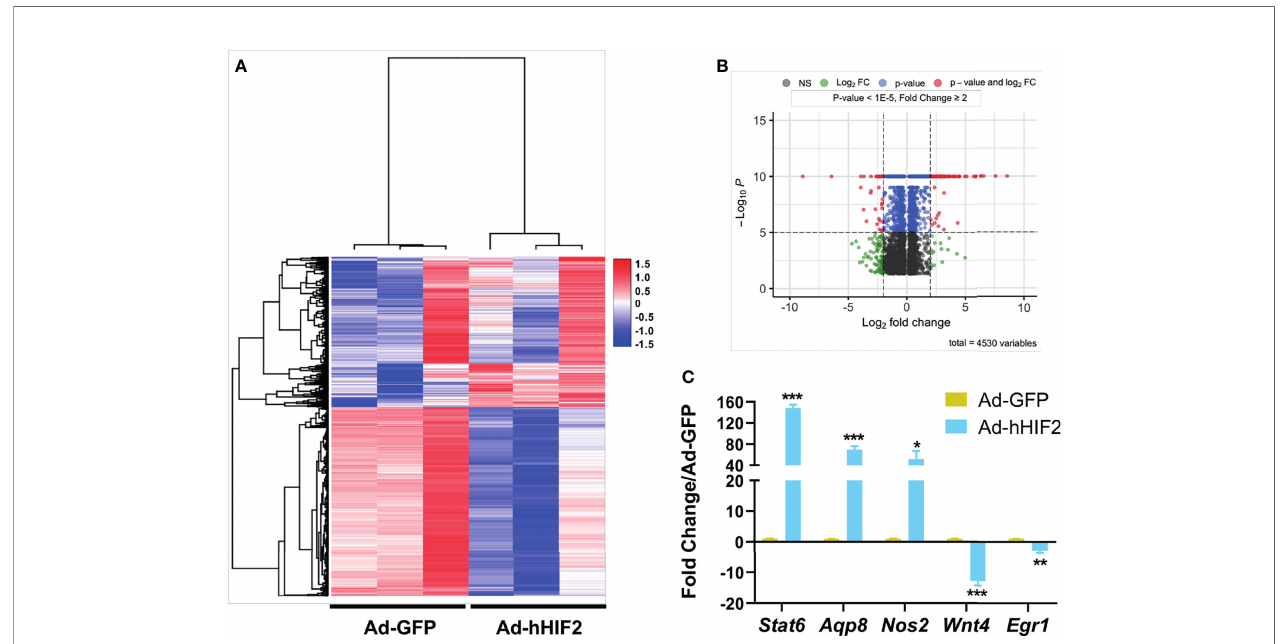
FIGURE 2 | Differentially expressed gene pro fi le in HIF2-overexpressing duodenal organoids. (A) Heatmap shows all the differentially expressed genes in duodenal organoids infected with Ad-hHIF2 or control Ad-GFP evaluated via RNA sequencing (n = 3 biological replicates/group). (B) Volcano plot of the differentially expressed genes. (C) qRT-PCR validation of the sequencing data in (A) . All error bars represent mean ± SEM. *P < 0.05, **P < 0.01, ***P < 0.001, by Student ’ s t test.